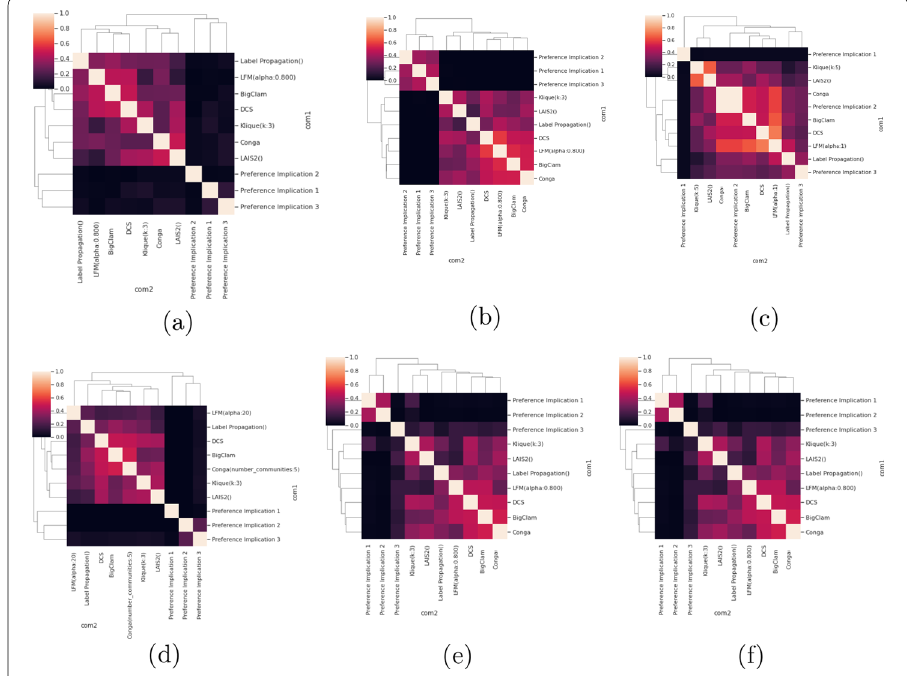
Fig. 11 This figure above is the NMI similarity matrix of the preference-value based method for six real networks. Here, a Zachary’s Karate Club, b Tortoise Social, c Facebook Caltech, d EU Road, e Facebook Nips and f Indo-china Webgraph. The three values of ν = [ 065,0.75,0.85 ] have been compared to other existing algorithms based on NMI and results are compared through this similarity matrix of clustering